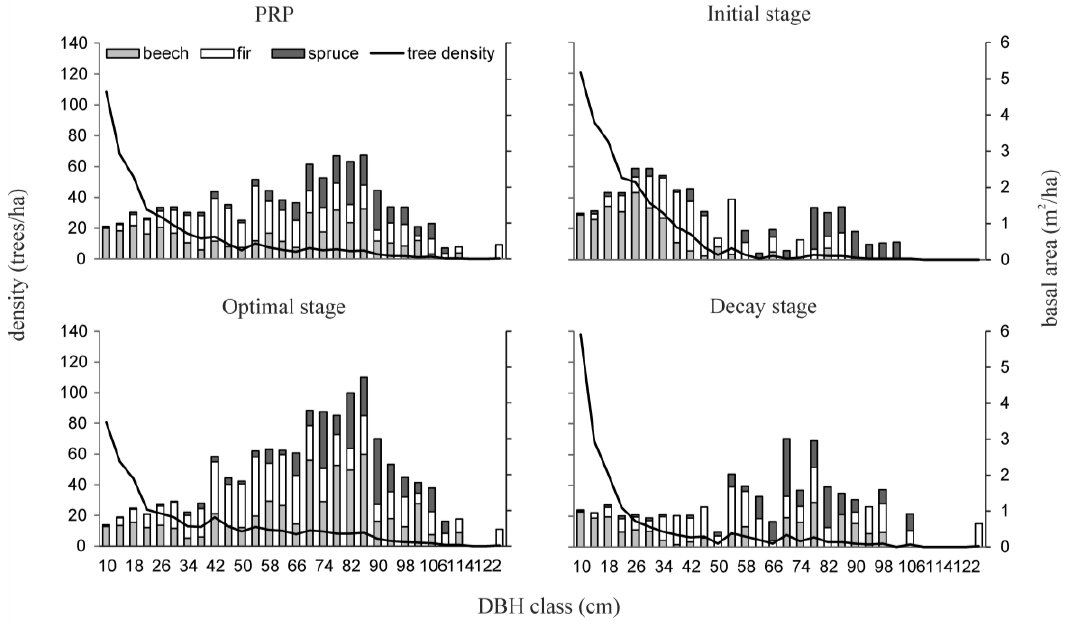
Figure 4. Tree density and basal area distributions according to diameter classes for the permanent research plot (PRP) and particular development stages.